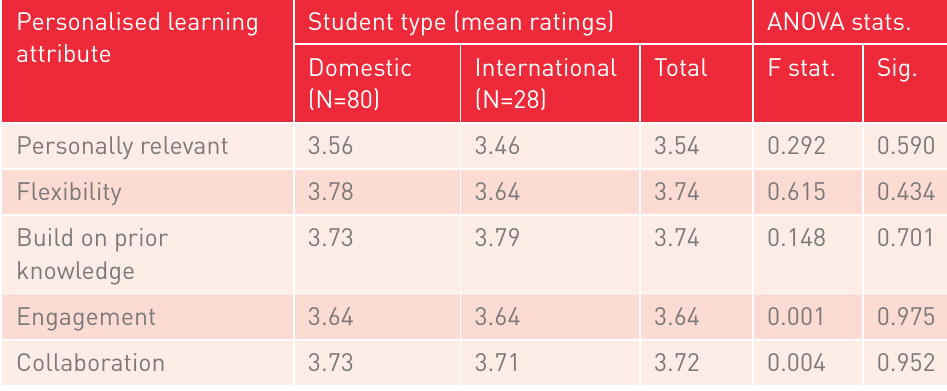
ANOVA test results for student